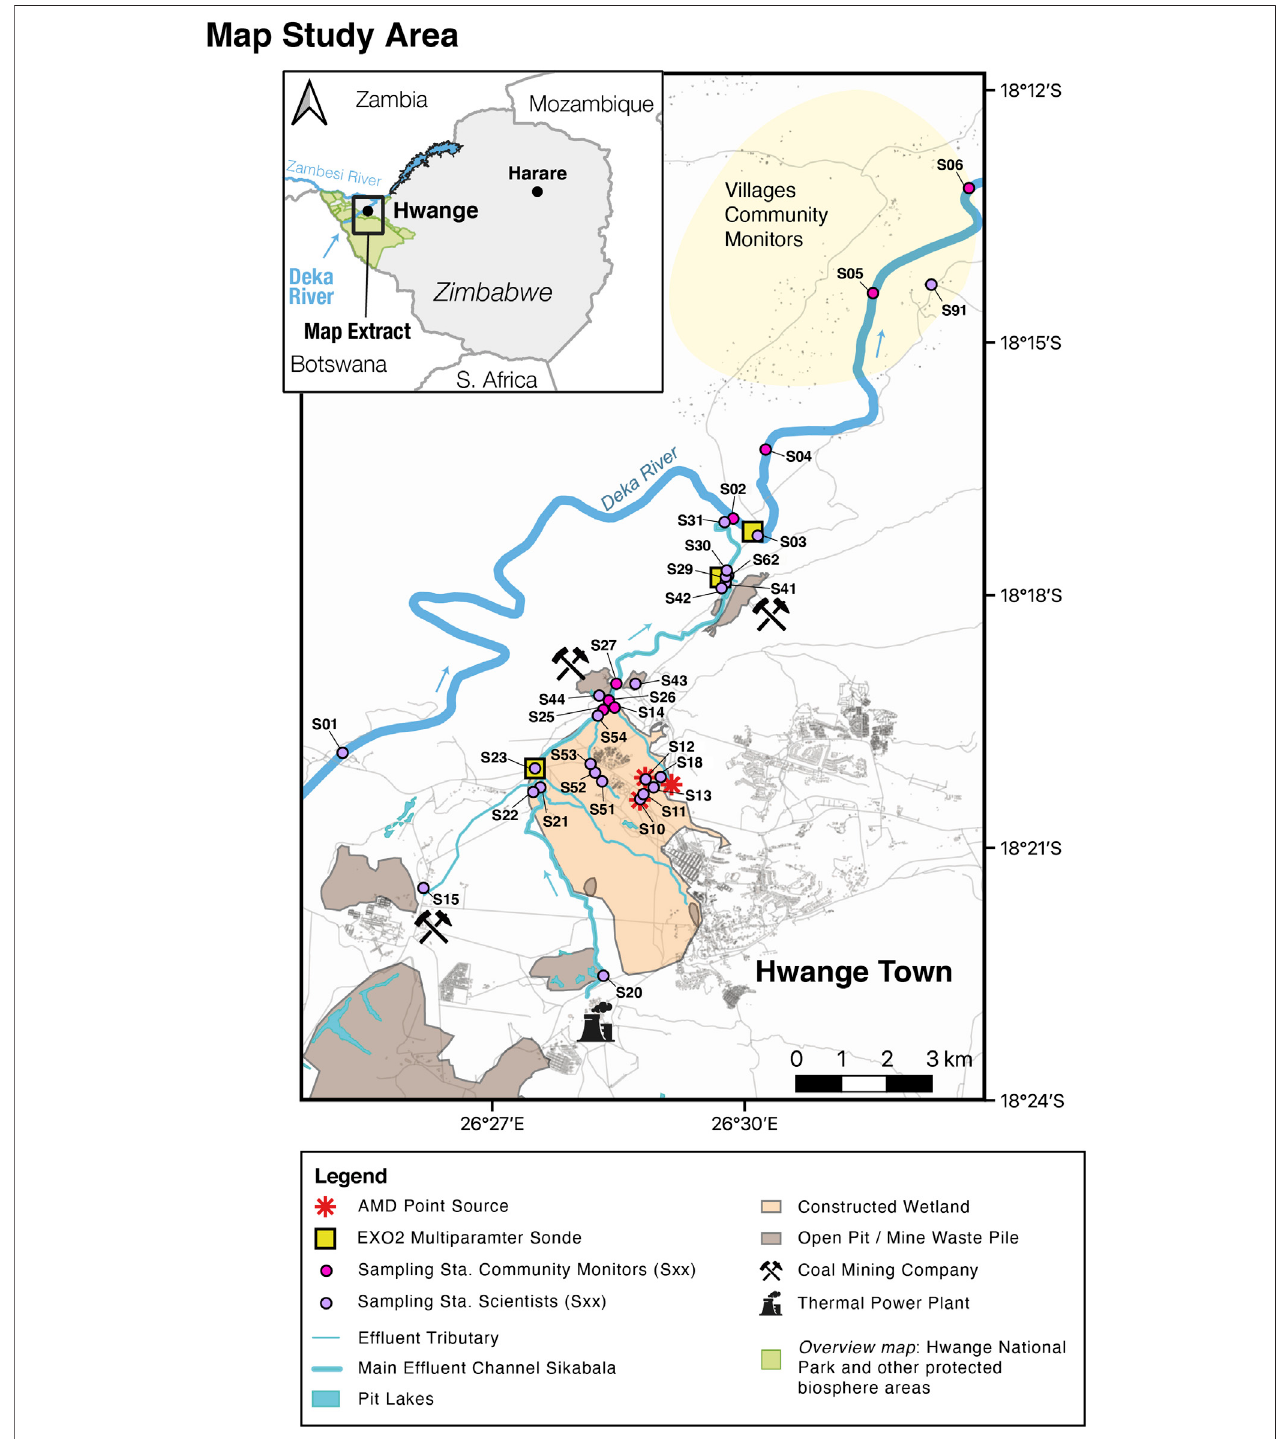
FIGURE1| OverviewmapillustratingcoalminingconcessionsandprotectednaturalreservesintheHwangeDistrict,WesternZimbabwe(topleft).Detailedmapof HwangeTownandsurroundingvillageswiththeDekaRiver,industrialsitesandlocationsofthesamplingstationforthewaterqualitymonitoringandtheplacementofthe in-situ sondes (center). QGIS maps contain administrative boundaries from DIVA-GIS (Hijmans et al., 2018) and infrastructure, buildings and roads from (Open Street Map,2021).Shape fi lesoftheprotectedbiosphereareaswereprovidedbytheProtectedPlanetInitiative(UNEP-WCMCandIUCN,2021).Somesamplingstations are located outside the map extent and are not included in this fi gure. Coordinates of all sampling stations are listed in the Supplementary Material .